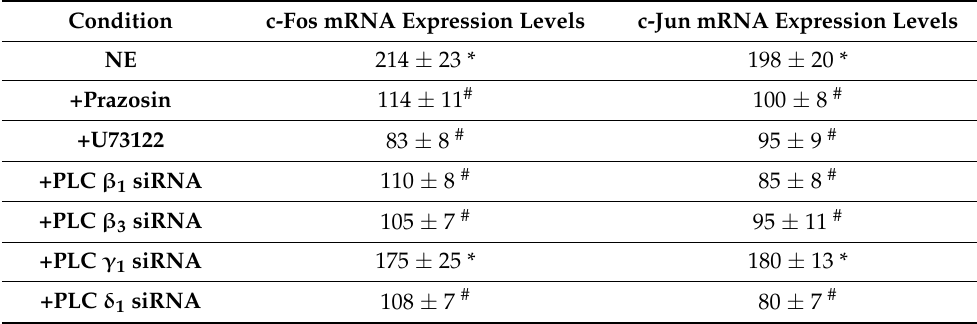
Table 3. Pharmacological and gene silencing interventions for the inhibition of increases in c-Fos and c-Jun gene expression levels in response to